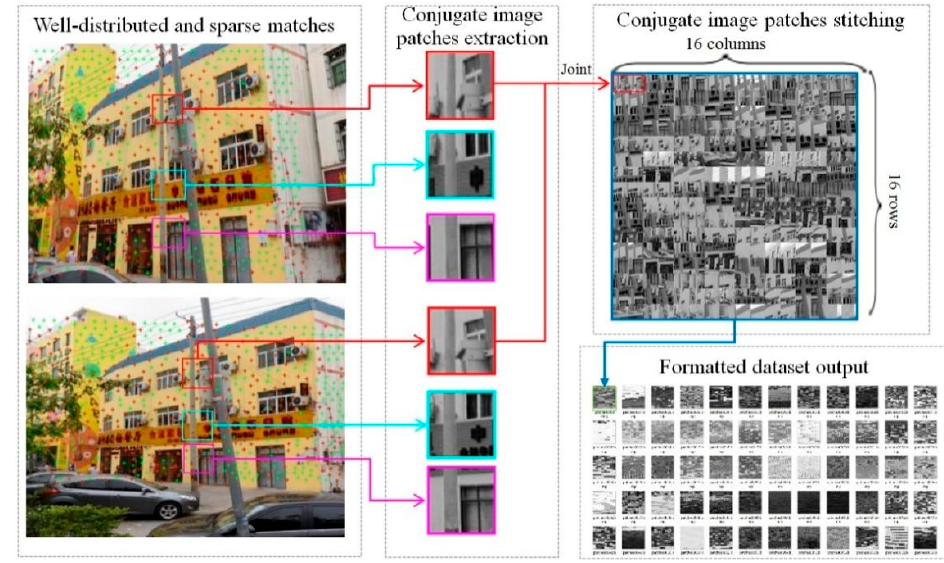
Figure 6. Algorithm for the automatic production of the dataset.